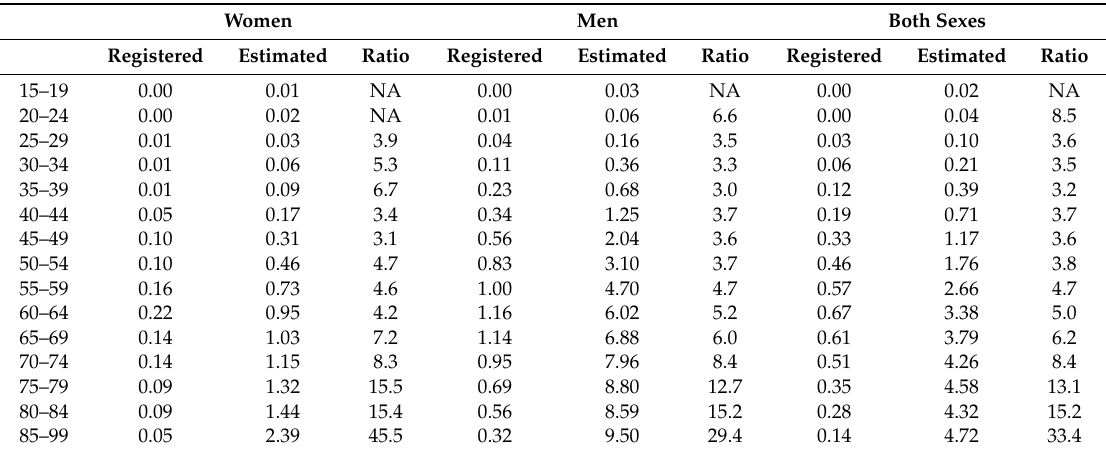
Table A3. Mortality rates of registered and estimated deaths of alcoholic cardiomyopathies by sex and